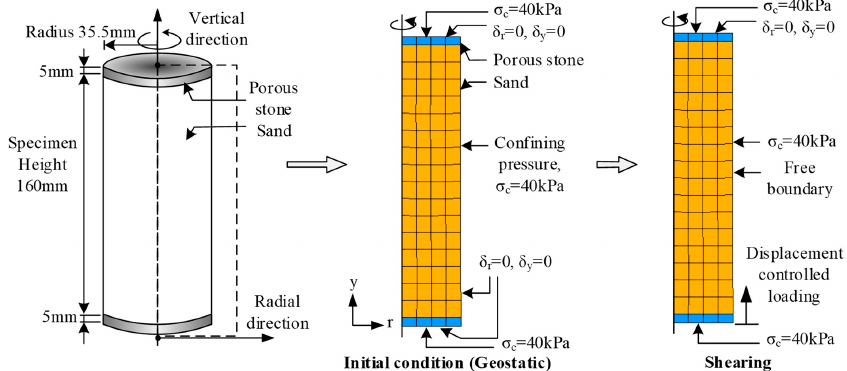
Figure 7. Schematic diagram of the triaxial compression test, and of its corresponding finite element model.